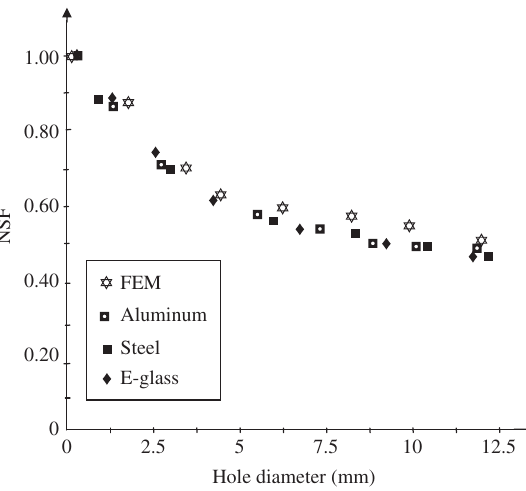
Figure 3 Comparison of NSF in tension for unbonded